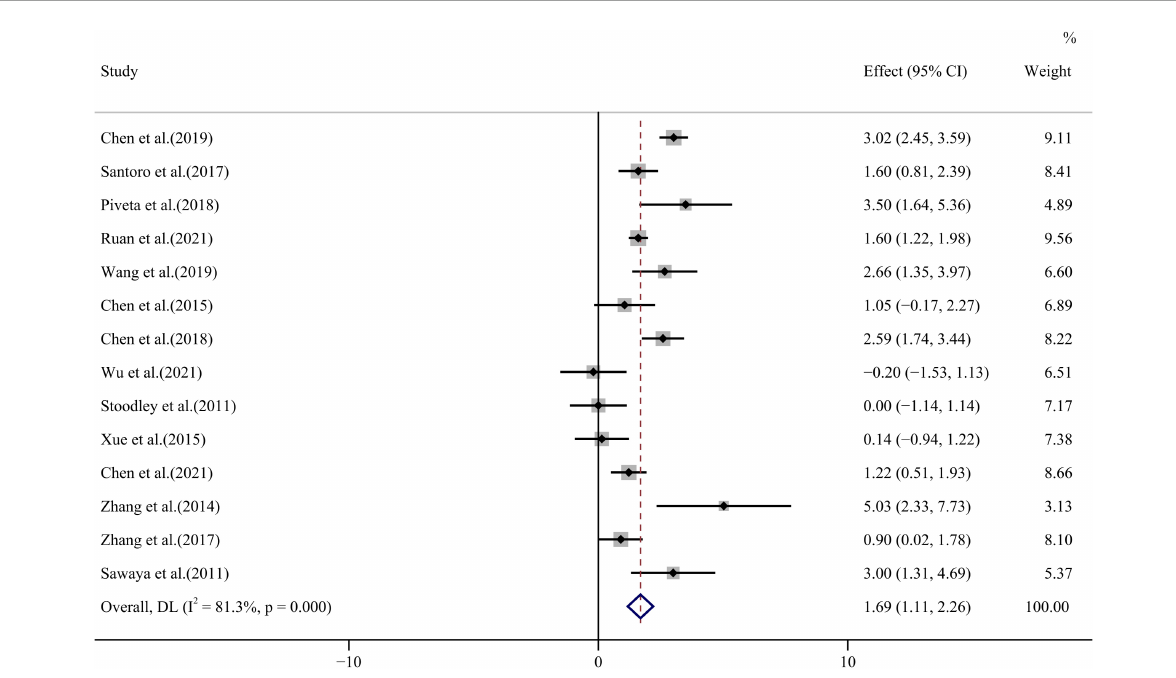
FIGURE6 GCS forest plot [Forest plot of weighted mean difference (WMD) of the association between GCS absolute value reduction and anthracyclines therapy].